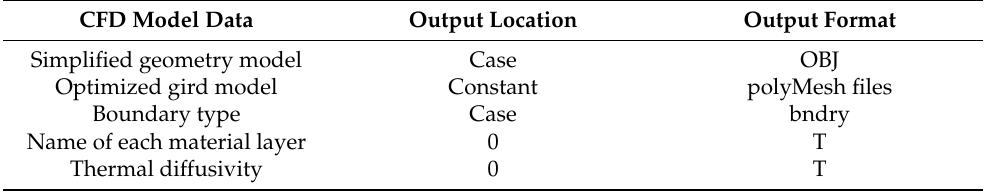
Table 1. The output of the extracted data, then converted from